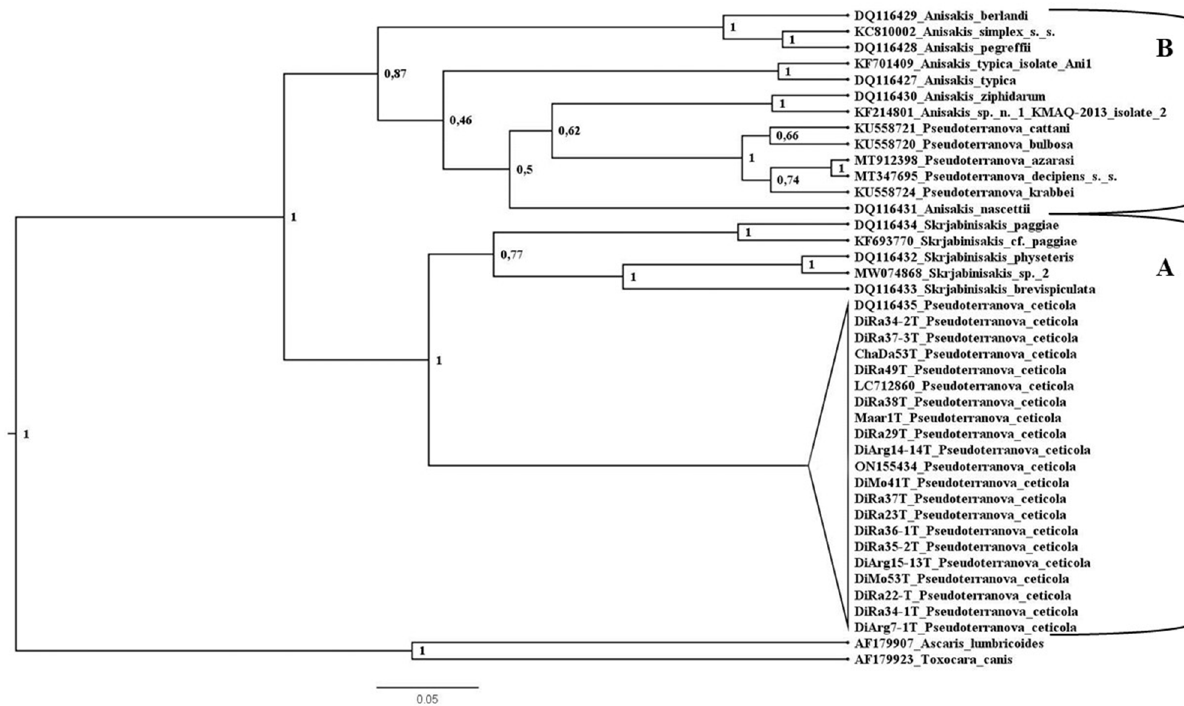
Figure 4. Phylogenetic tree from Bayesian inference based on cox 2 sequences. A : clade A ; B : clade B . Figure 4 was created in Figtree v1.4.4 (http:// tree. bio. ed. ac. uk/ softw are/ figtr ee/).